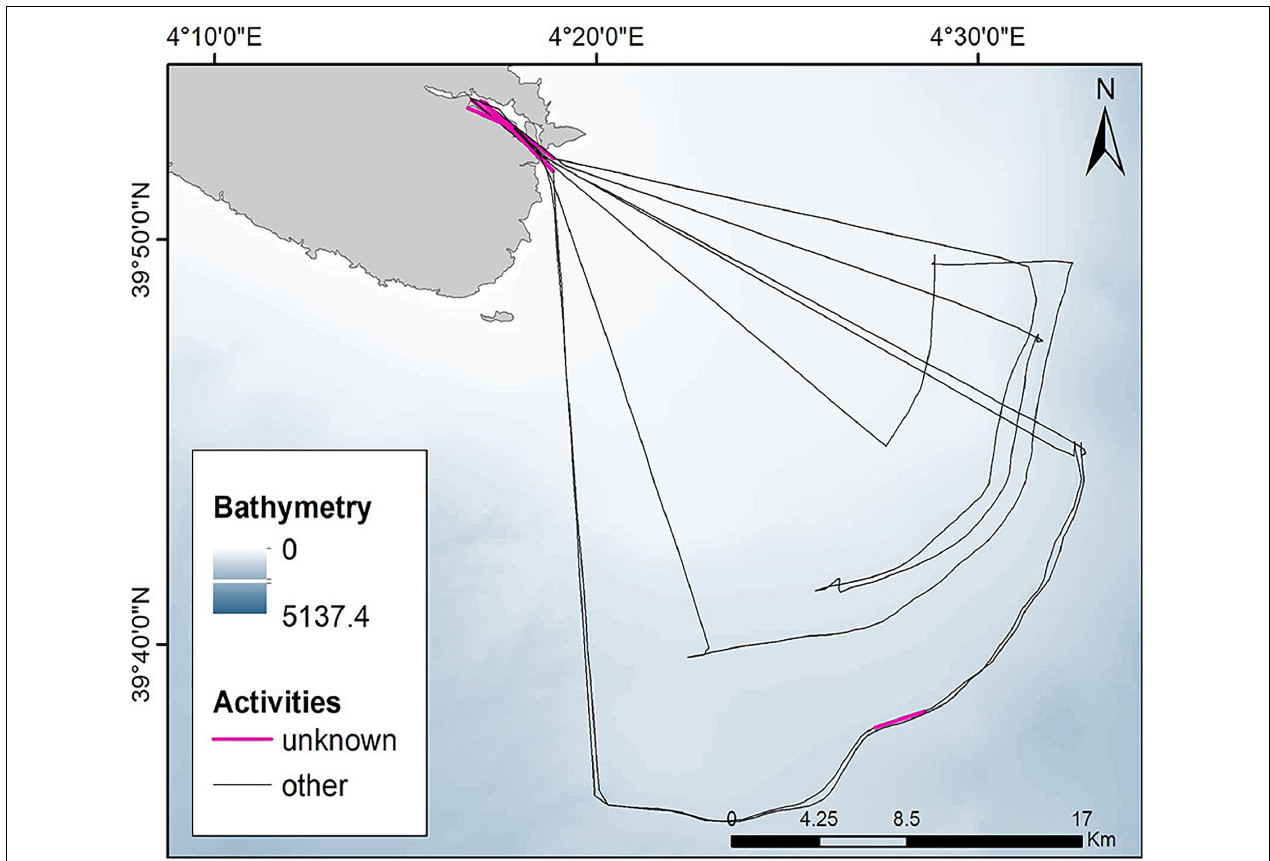
FIGURE 1 | Weekly tracking layer of a trawler. Segments exceeding 30 min were labeled as